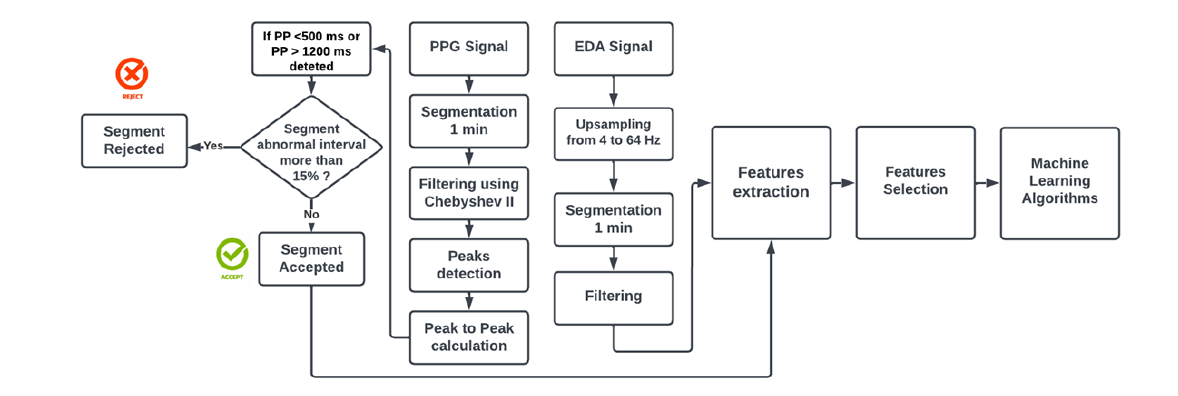
Figure 2. Flowchart for PPG and EDA pre-processing.